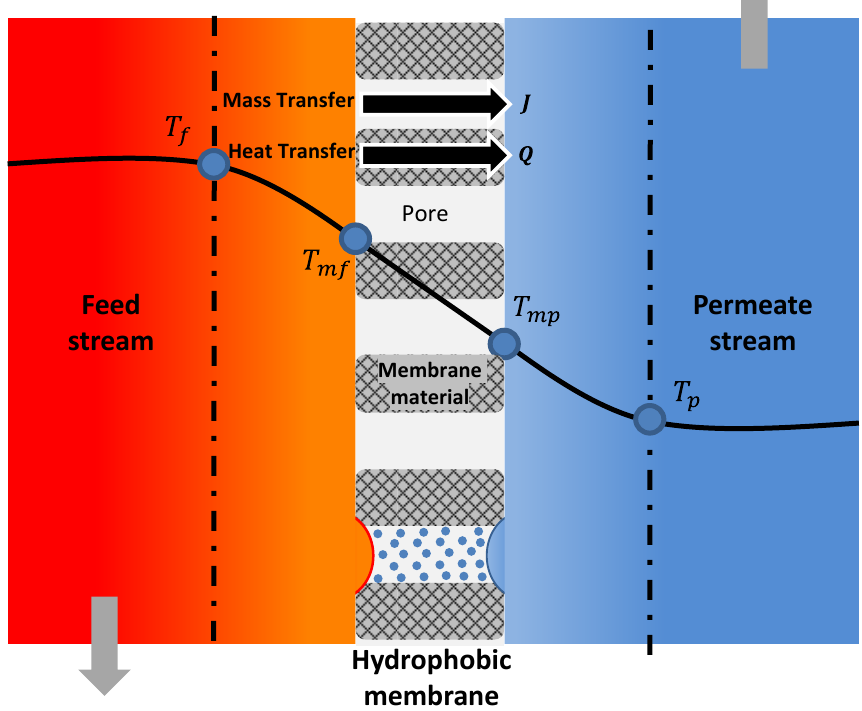
Figure 2. Schematic diagram of the transport mechanism for the direct contact membrane distillation (DCMD) process.